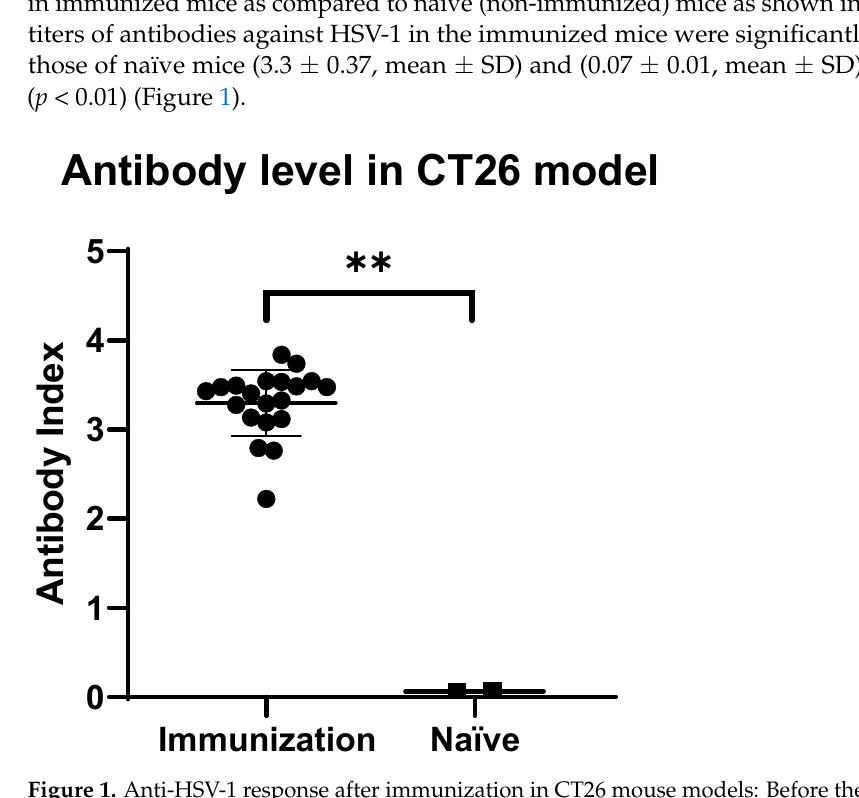
Figure 1. Anti-HSV-1 response after immunization in CT26 mouse models: Before the tumor implantation, serum was randomly collected from 2 naïve mice and 20 immunized mice. The anti-HSV-1 antibody level was detected using Mouse/Rat HSV-1 IgG ELISA kit. ** p < 0.05.